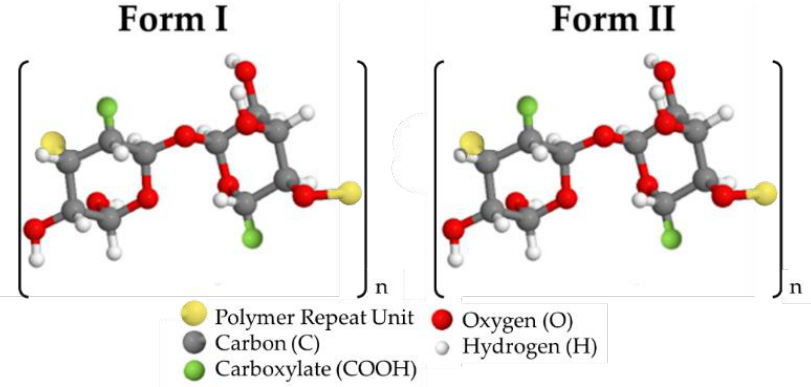
Figure 1. The chemical structure of Form I and Form II OTO-CNM polymers.